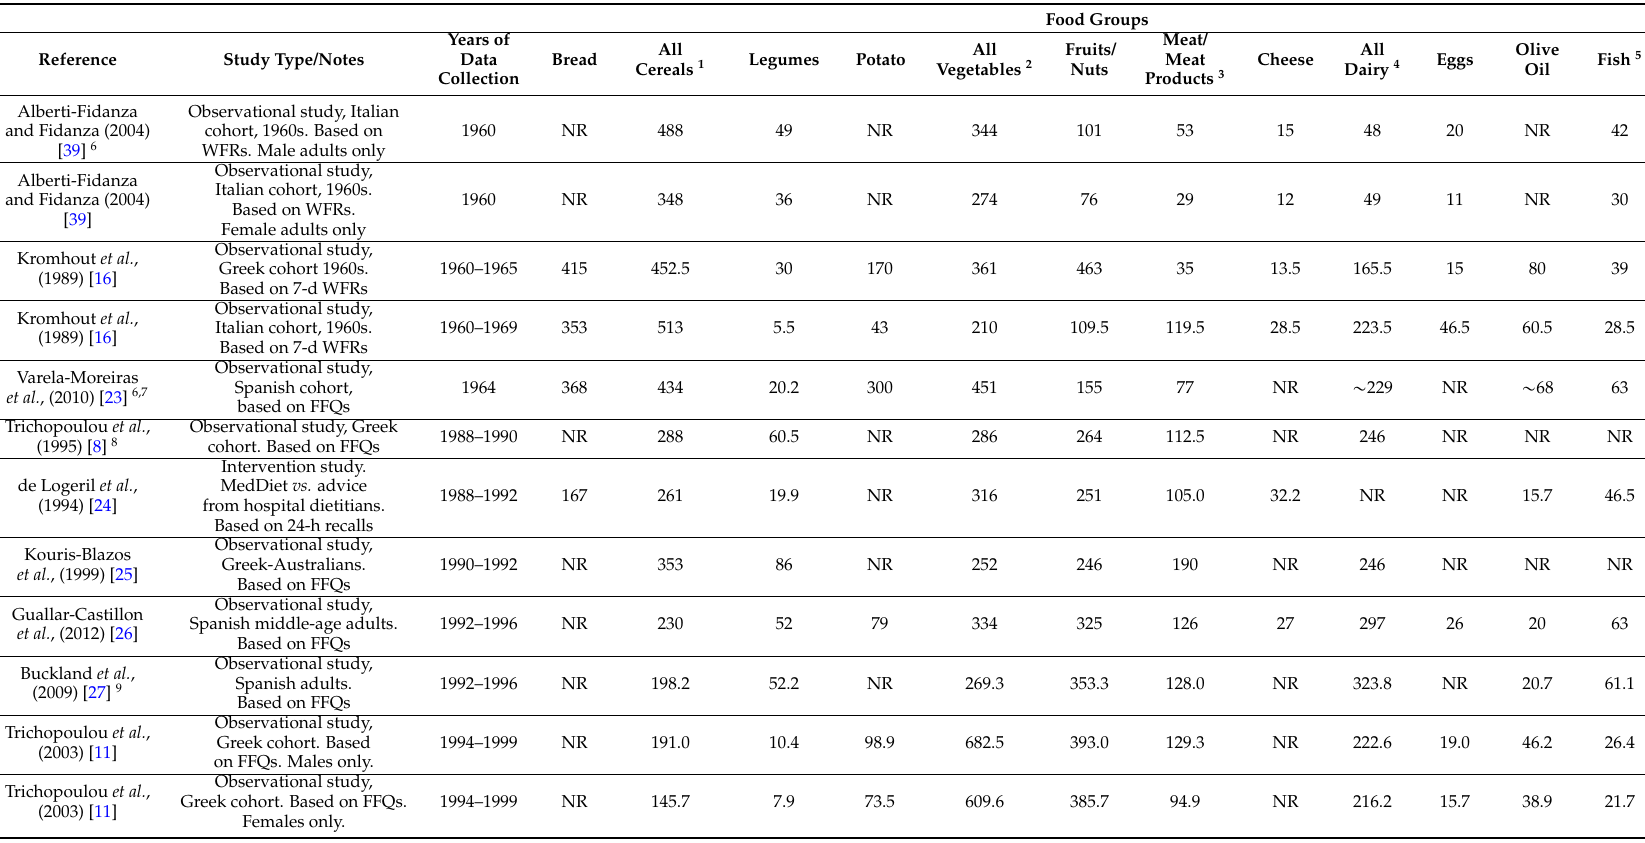
Table 2. Grams per day of key foods and food groups in the Mediterranean diet, in order of date data was collected, including mean ˘ SD.